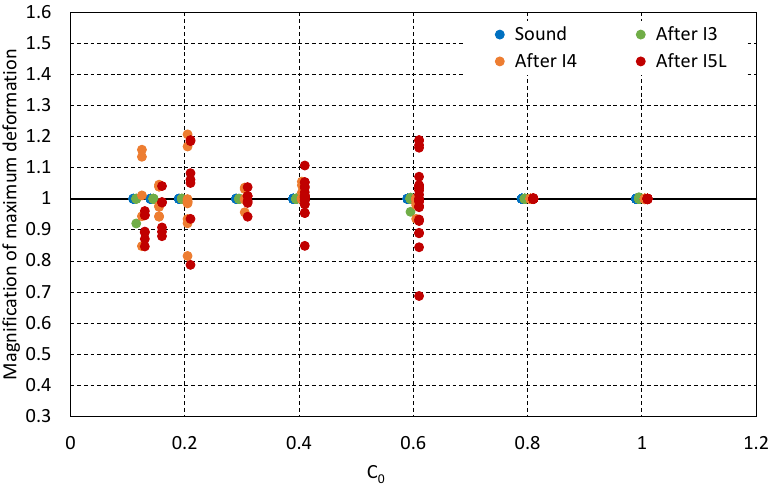
Figure 13. Magnification of maximum deformation. If we look at the mean value for the response multiplier, the repetitive deformations from multiple small and medium earthquakes are seen to have almost no effect on the maximum response deformation at the time of large-scale earthquakes, regardless of the performance level of the wooden housing. In this analysis, as repeated small deforma- tions are shown not to lower strength at the time of large deformations, their impact is considered to be small. If we focus on the maximum response multiplier, we saw that even if earthquakes of seismic intensity 3 were repeated for housing of any performance level, an increase in response deformation was not seen. In the case where earthquakes of seismic intensity 4 were repeated, an increase in response deformation was seen in houses of C 0 = 0.2 or below. In the case of repeated earthquakes with a seismic intensity of 5 lower, an increased response was seen in houses of C 0 = 0.6 or below. However, in the case of high-performance housing, as the response deformation was small in the sound case, the influence was considered to be